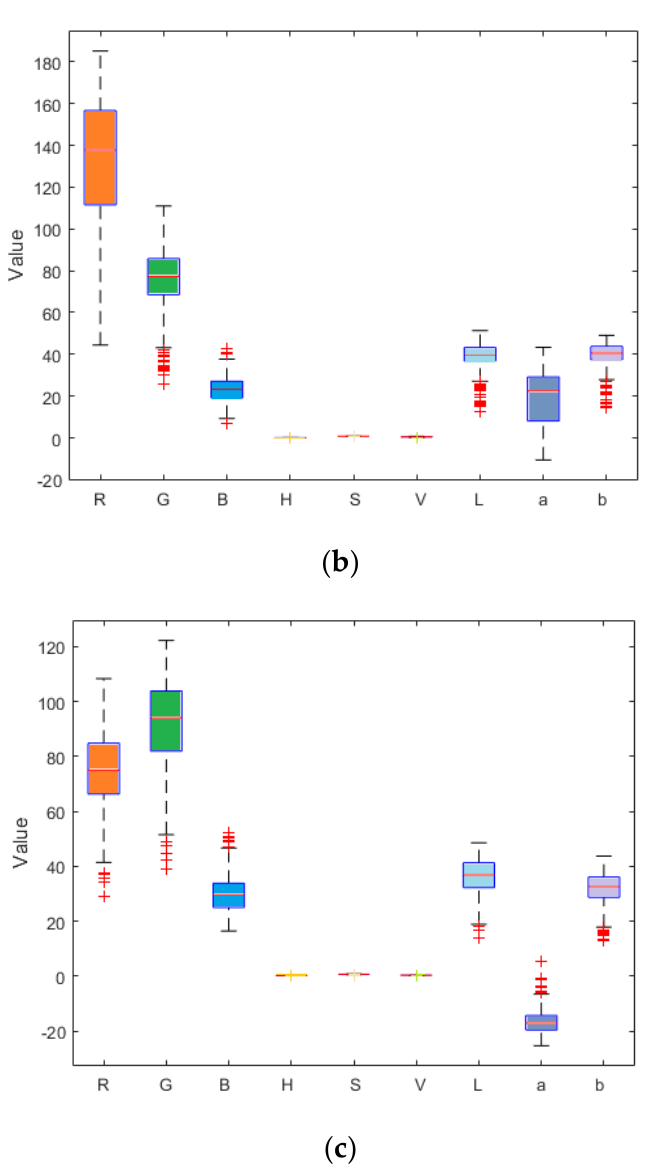
Figure 7. Box plots of numerical values of nine components of the ripe fruit ( a ), half-ripe fruit ( b ), and unripe fruit ( c ).